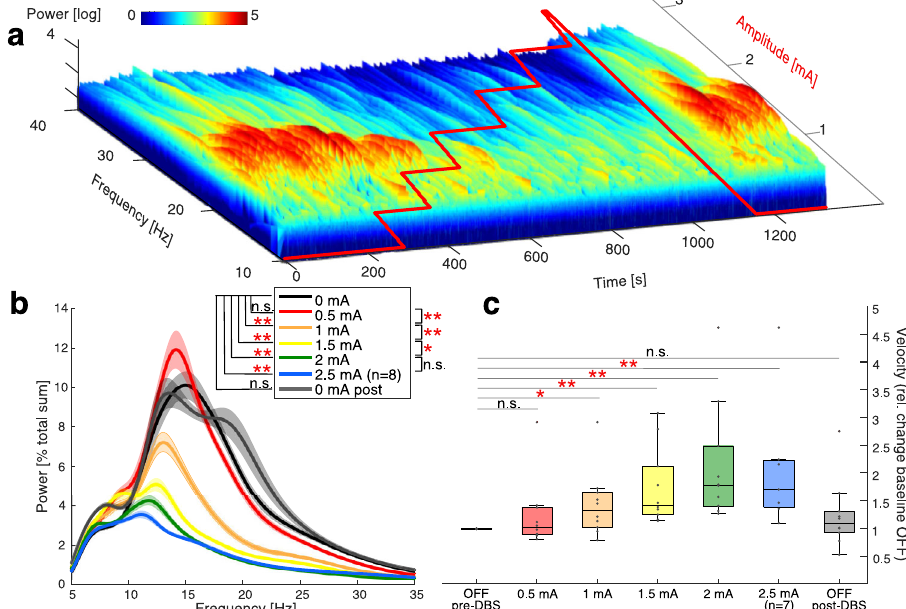
Fig. 1 Stepwise stimulation increase is mirrored in the stepwise suppression of beta frequency band activity and stepwise improvement of motor performance. a Stimulation amplitude layered as a red line on the time – frequency plot of a representative recording session in a PD patient during monopolar review b Averaged power spectra for 30 sec mean resting state power per stimulation step across bradykinetic patients (10 STN), (mean beta-band activity [% total sum] by stimulation step: OFF: 4.31 ± 1.2%, 0.5 mA: 4.09 ± 1.06%, 1 mA: 2.27 ± 0.83%, 1.5 mA: 1.53 ± 0.54%, 2 mA: 1.17 ± 0.41%, 2.5 mA: 1.12 ± 0.41%, OFF post-DBS: 4.64 ± 2.22%) c: Mean velocity improvement in bradykinetic patients (mean velocitiy relative to baseline 0.5 mA = 1.24±0.63; 1 mA = 1.44 ± 0.6; 1.5 mA = 1.76 ± 0.69; 2 mA = 2.15 ± 1.06; 2.5 mA = 2.1 ± 1.2, OFF post-DBS: 1.24 ± 0.61, central mark in the boxplot is the median, edges are 25th/75th percentile), with paired permutation